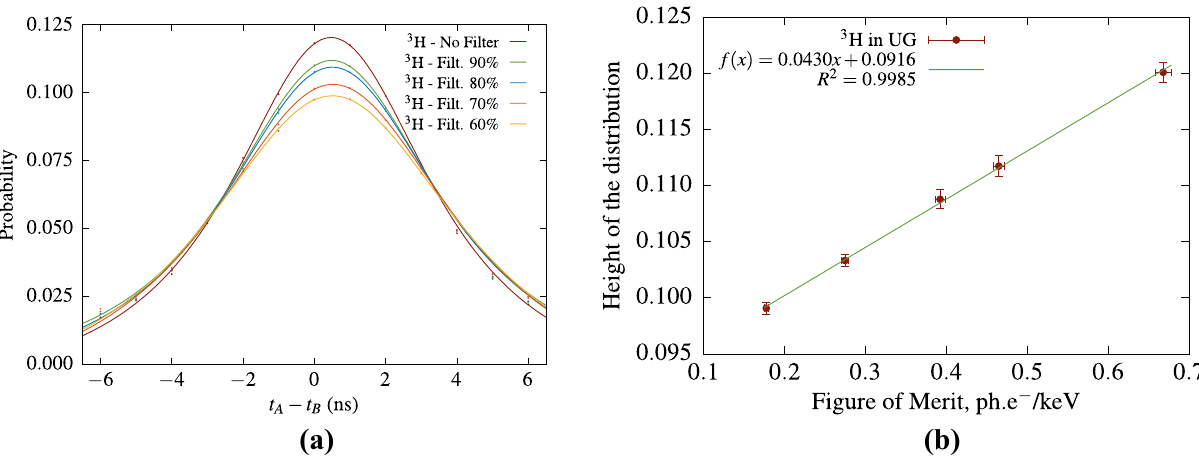
3 Figure 7. Cross-correlation studies with H in Ultima Gold cocktail and various levels of grey filters. The cross-correlation spectra ( a ) are fitted within ± 3 ns with a Voigt profile in order to evaluate the height of the distribution.